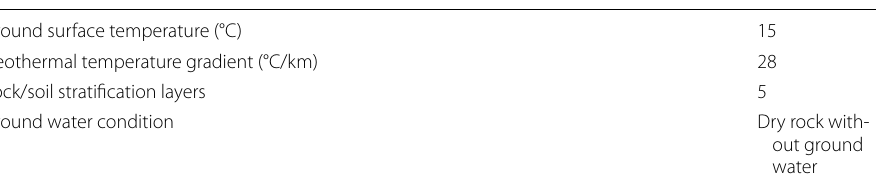
out ground water